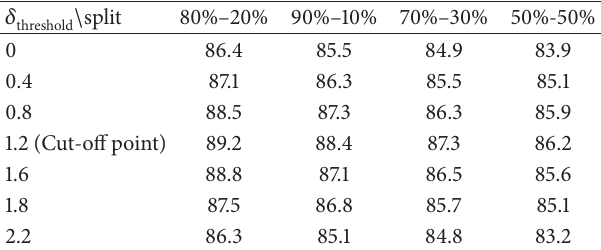
Table2:ComparisonresultsofCFRCSwithdifferent 𝛿 %).